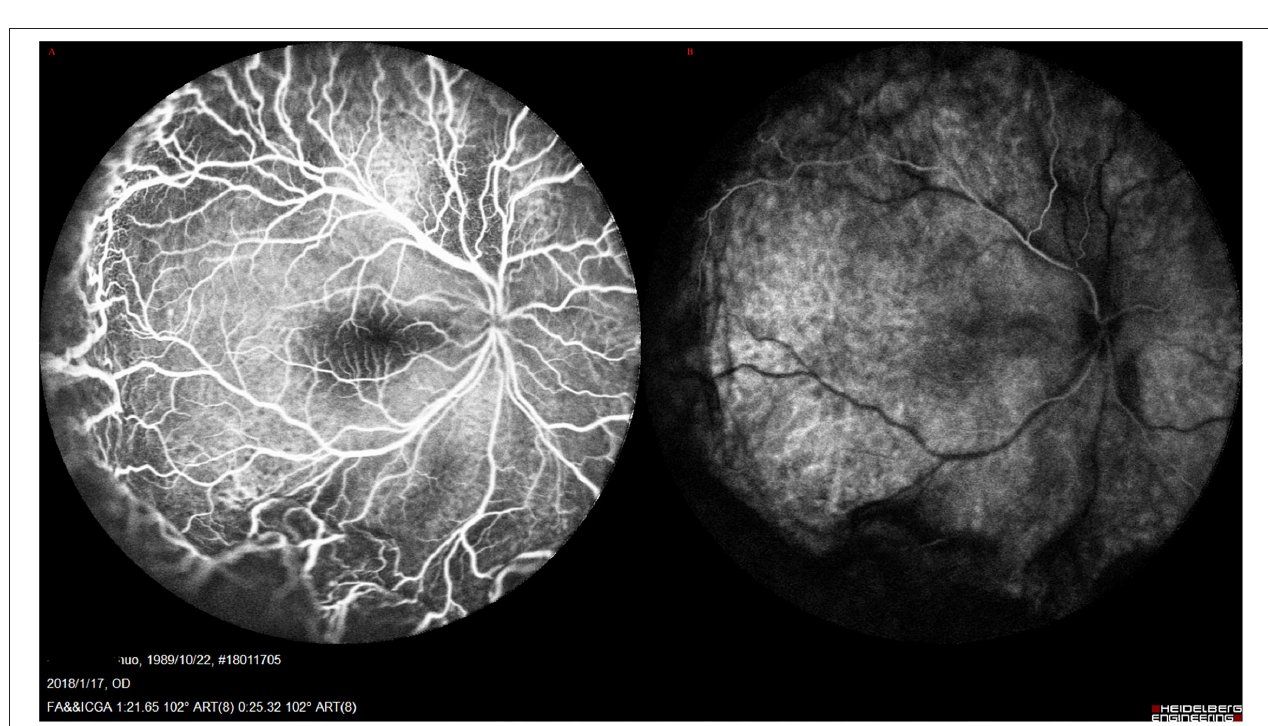
effusion and ciliary body detachment, similar to type 1, in the affected eyes. In all patients, CDU showed normal-sized eyes, with marked thickening of the sclera (mean 2.7 mm) and choroidal and retinal detachment in all eyes ( Figure 7